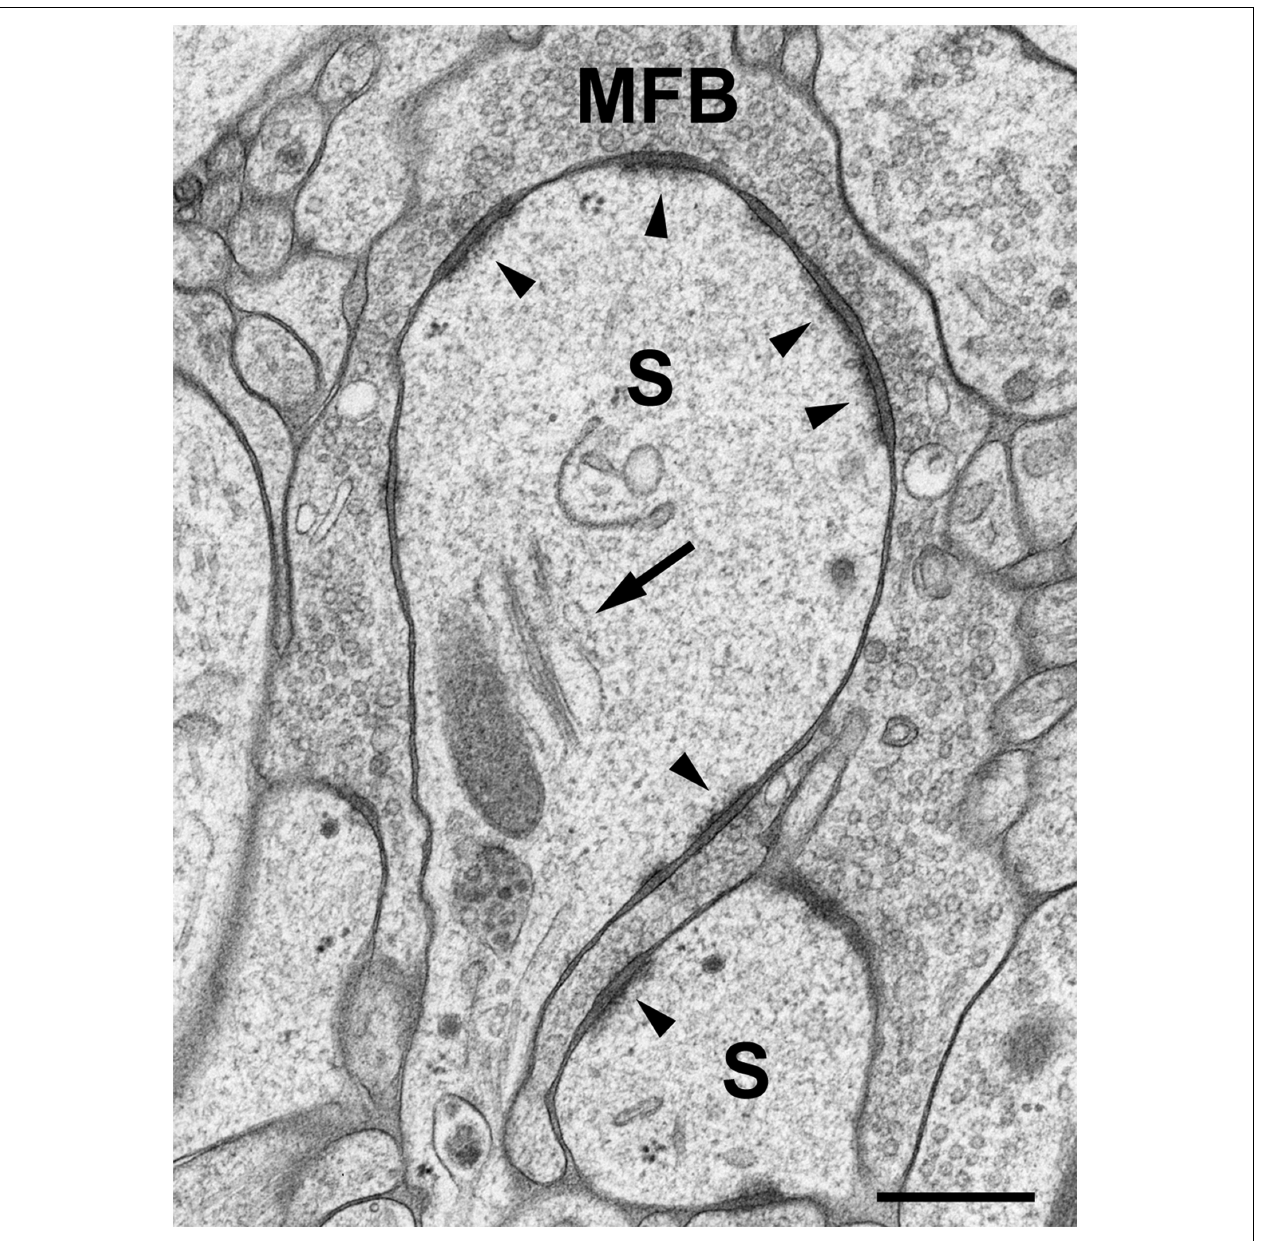
Arrowheads indicate active zones. Note the widening of the extracellular space at synaptic sites and prominent postsynaptic densities that extend fine filiform protrusions into the spine cytoplasm. Occasionally, ribosomes are seen near active zones. Scale bar: 200